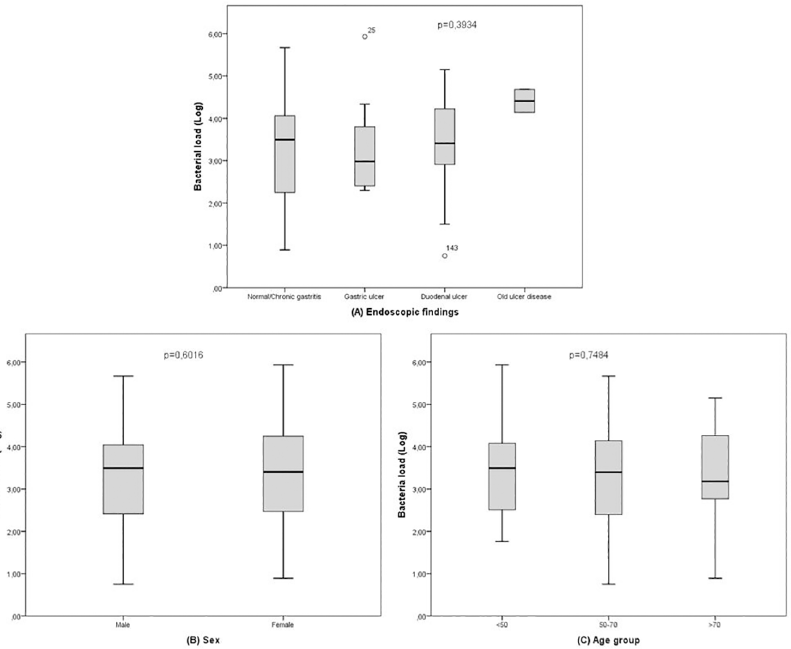
Fig 3. Relationship between average H . pylori bacterial load and endoscopic findings, sex and